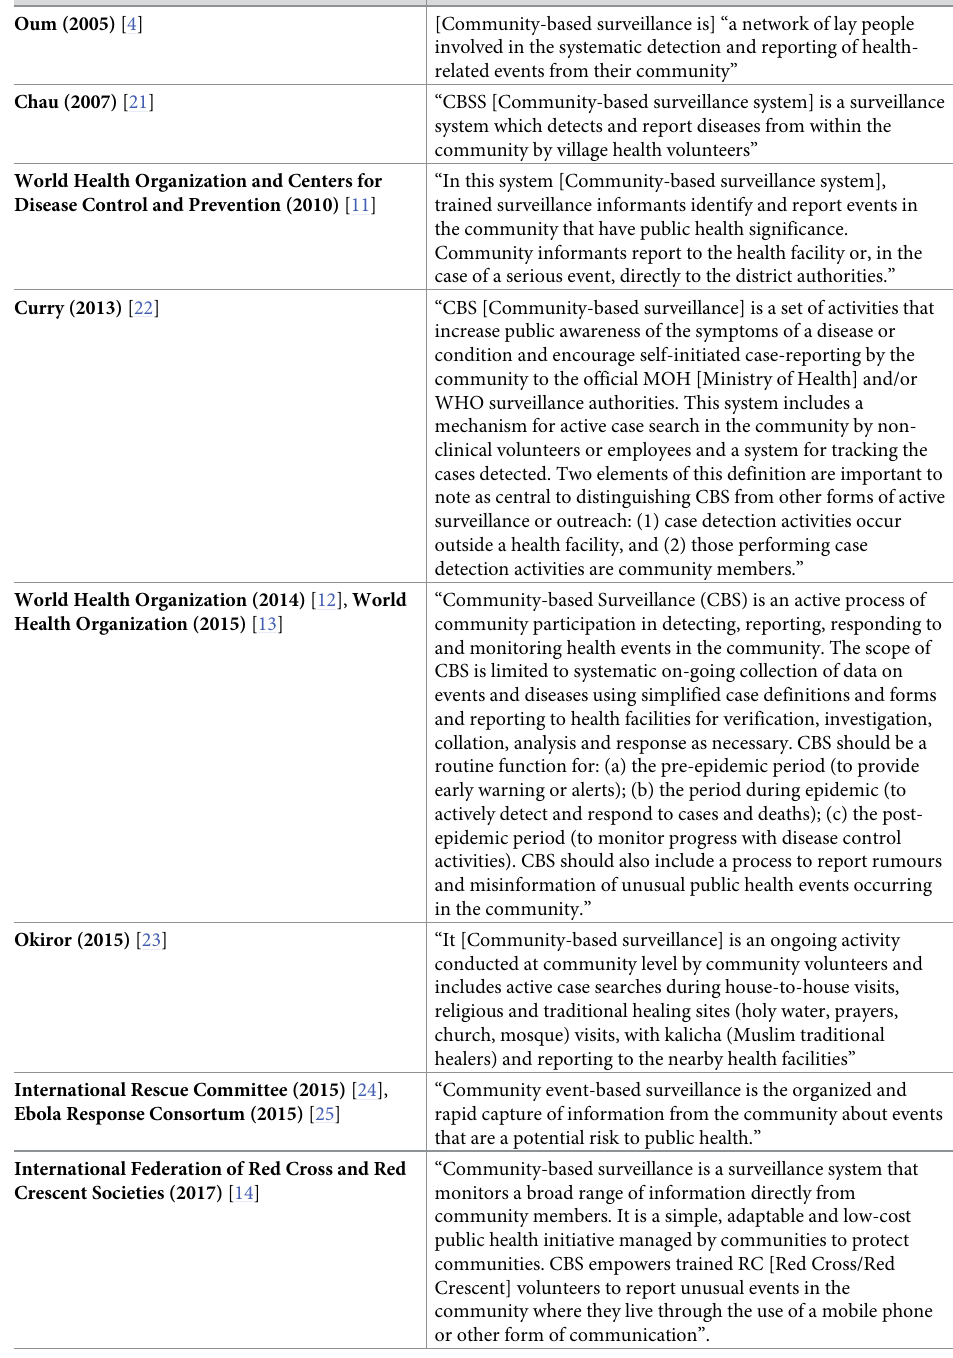
Table 1. Definitions of the term used to denote the approach of engaging community members in identifying and reporting health events occurring in their community for public health surveillance